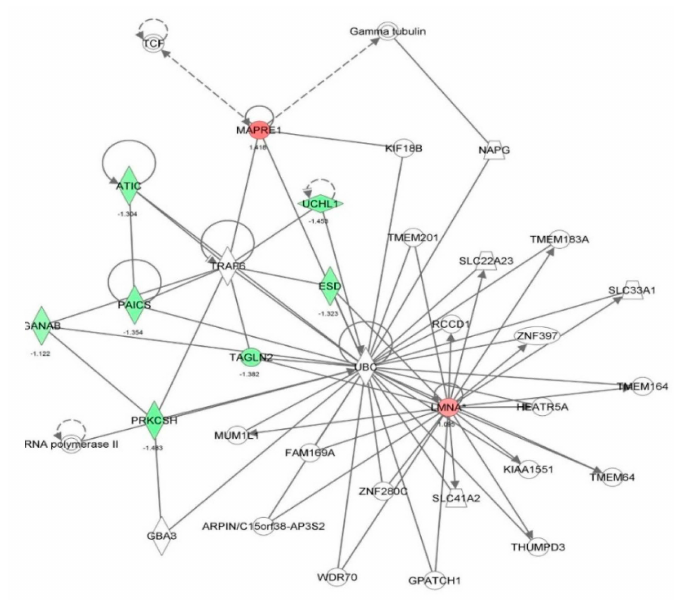
Figure 24. Vancomycin regulated carbohydrate metabolism, small molecule biochemistry, and cell morphology. Red indicates an up-regulation; green indicates a down-regulation. The intensity of green and red colors indicates the degree of down- or up-regulation. Solid arrow indicates direct interaction and dashed arrow indicates indirect interaction.